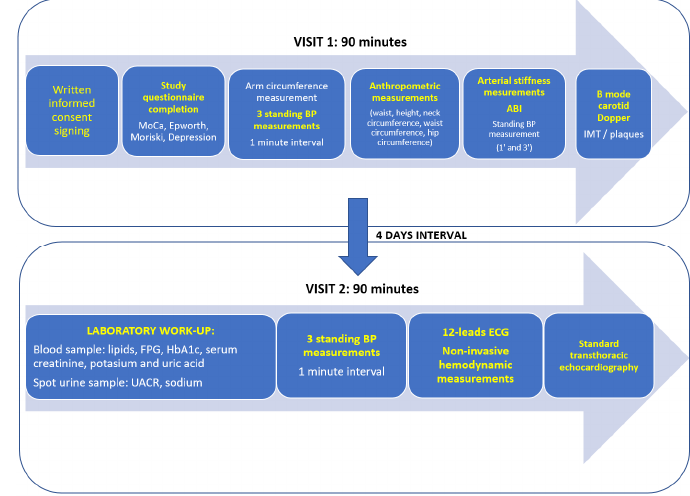
Figure 1. Study evaluation workflow in SEPHAR surveys. BP = blood pressure, ABI = ankle-brachial index, IMT = intima-media thickness, FPG = fasting plasma glucose, UACR = urinary albumin/creatinine ratio, ECG = electrocardiogram, MoCA = Montreal Cognitive Assessment, ECG = electrocardiogram.